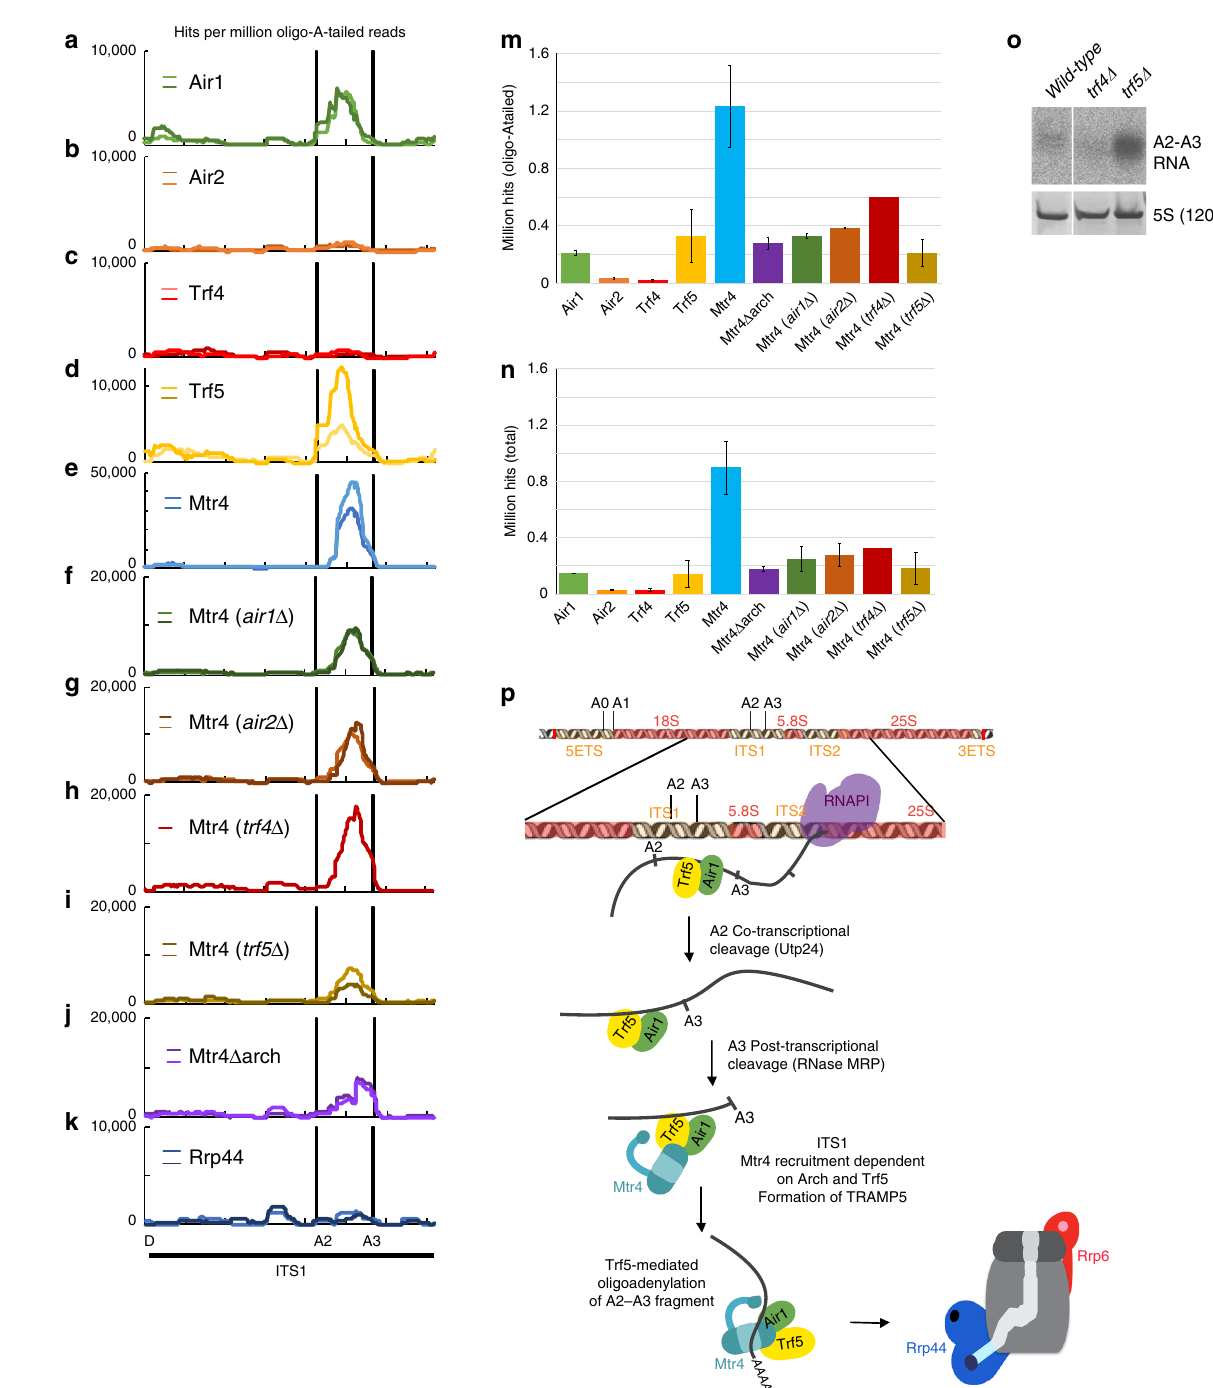
Fig. 3 TRAMP interaction sites on the pre-rRNA ITS1 region. a – k Distribution of non-encoded oligo(A)-tailed reads, normalized to millions of total mapped reads, across the ITS1 region of the pre-rRNA. The graph shows the distribution of reads recovered with the indicated TRAMP components ( a – e ), Mtr4 in strains lacking the indicated TRAMP components ( f – I ), Mtr4 lacking the arch domain ( j ), and Rrp44 ( k ). Scale is linear. A diagram of the pre-rRNA region is also shown. Two independent replicates are shown in panels as light and dark colored lines. m , n Hits per millions oligo(A)-tailed reads ( m ) and total reads ( n ) encompassing the A2 – A3 region of ITS1 extended by 10 nt from each side were summed and are exhibited as a bar diagram. Two individual replicates were averaged, with standard deviation shown as error bars (except for Mtr4 ( trf4 Δ ) for which only one experiment was performed). o Northern blot analysis with probe for the A2 – A3 fragment (probe for 5S rRNA was used as a loading control). p Model for surveillance within ITS1. Trf5 and Air1 are recruited co-transcriptionally to the A2 – A3 region. Following A2 cleavage, ribosome synthesis factors are released, freeing site A3. Mtr4 is recruited, probably via protein – protein interactions involving Trf5 and an Mtr4 arch interaction. Following A3 cleavage, Trf5 oligo-adenylates the free 3 ′ end prior to degradation by the